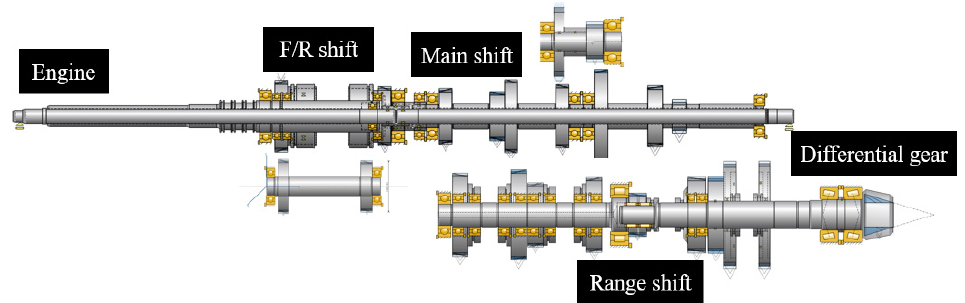
Figure 5. Simulation model of the 86 kW class agricultural tractor transmission developed in this study.